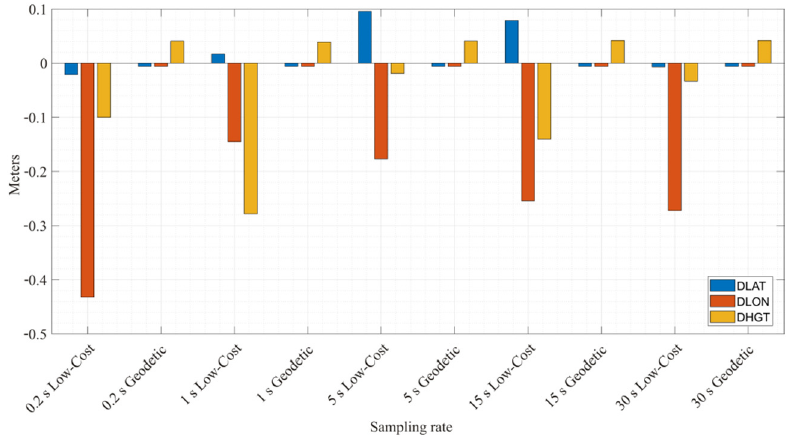
Figure 11. Difference between estimated and precise positions of low-cost and geodetic receivers by processing with PPP-kinematic mode.